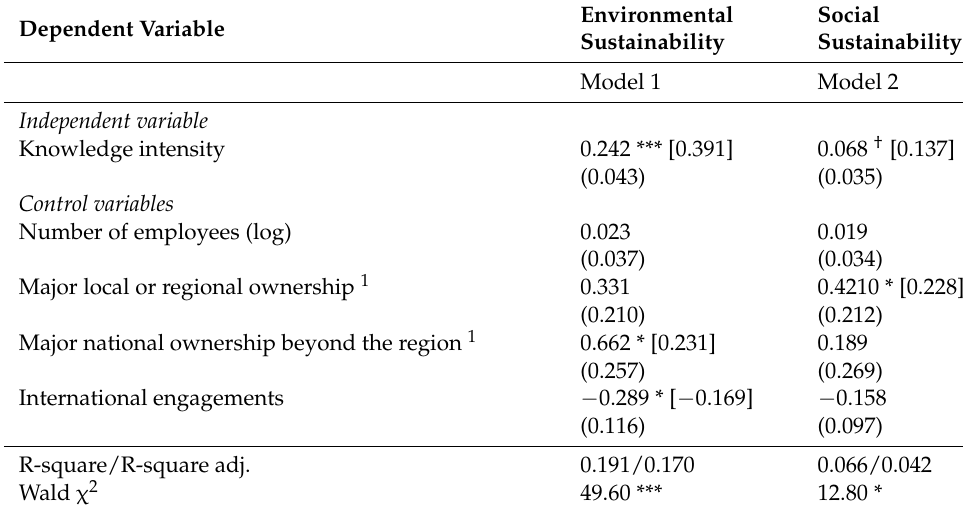
Table 3. Bootstrapped ordinary least square (OLS) regressions, including only the aquaculture